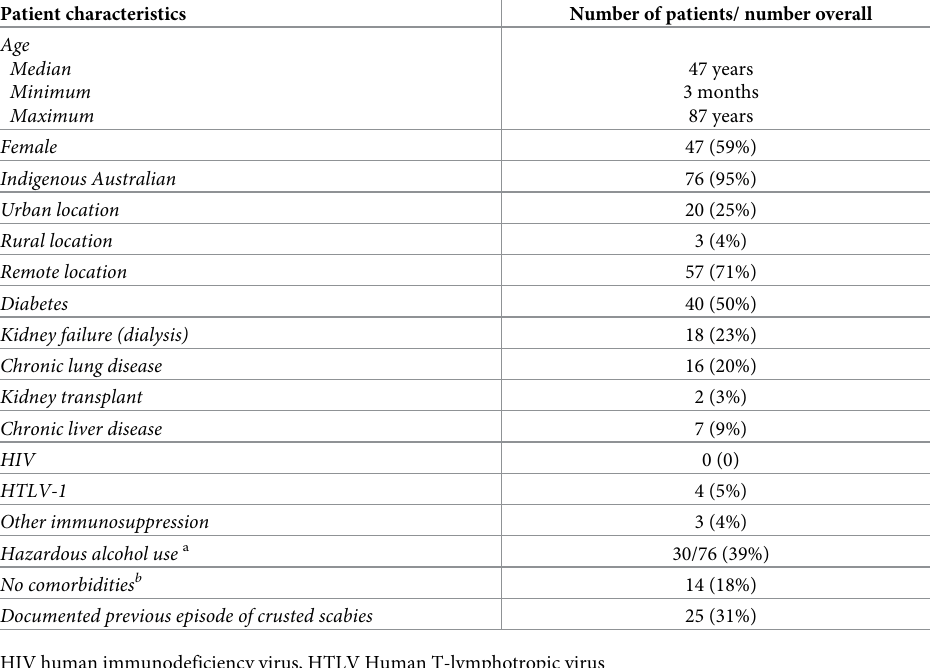
Table 1. Demographic features and comorbidities of 80 patients with crusted scabies,